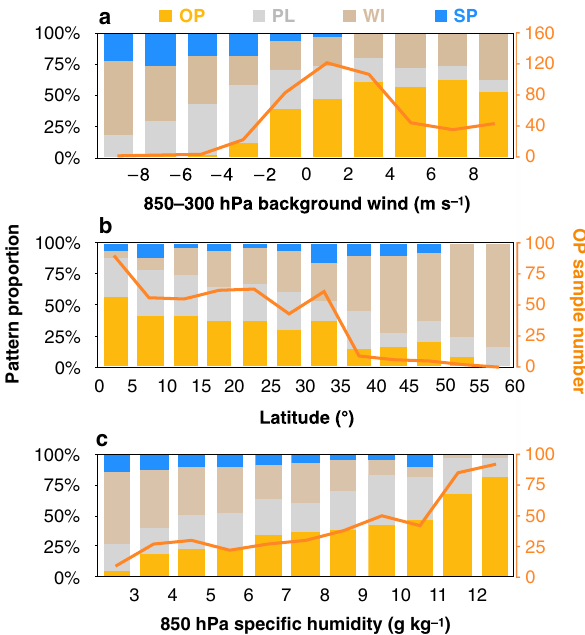
Fig. 3 | Responses ofthe diurnal pattern proportion to environmental factors. Theenvironmentalfactorsinclude a 850 – 300hPabackgroundwind, b latitudeand c 850hPaspeci fi chumidity.OP,PL,WI,andSPdenoteoffshorepropagation,phase- locked, weak or incoherent and shoreward propagation diurnal patterns, respec- tively. The corresponding sample number of OP is indicated by orange lines. Positive (negative) values of the averaged 850 – 300hPa background wind indicate the offshore(onshore)component ofthe background wind.The background wind andspeci fi chumidityofeachsamplewerecalculatedwithintherectangleenclosed bytheselectedcoastlineanditsoffshoredirection(perpendiculartothecoastline) up to